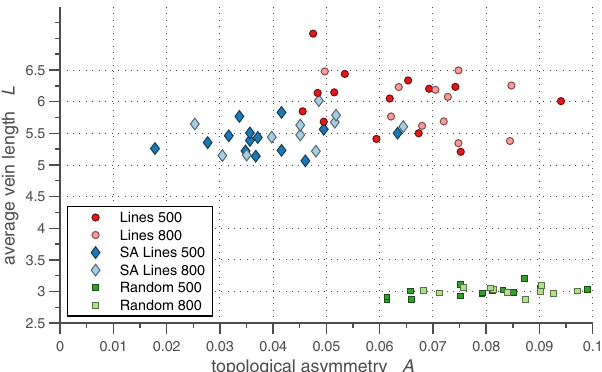
FIG. 13. Average vein length L versus topological asymmetry A for various edge-weight assignment models on genus-2 toroidal topologies. The number of nodes on each graph was approx- imately N ≃ 500 or N ≃ 800 . Blue: SA lines 500; light blue: SA Lines 800; red: lines 500; pink: lines 800; green: random 500; light green: and random 800. L and A are not sensitive to the graph